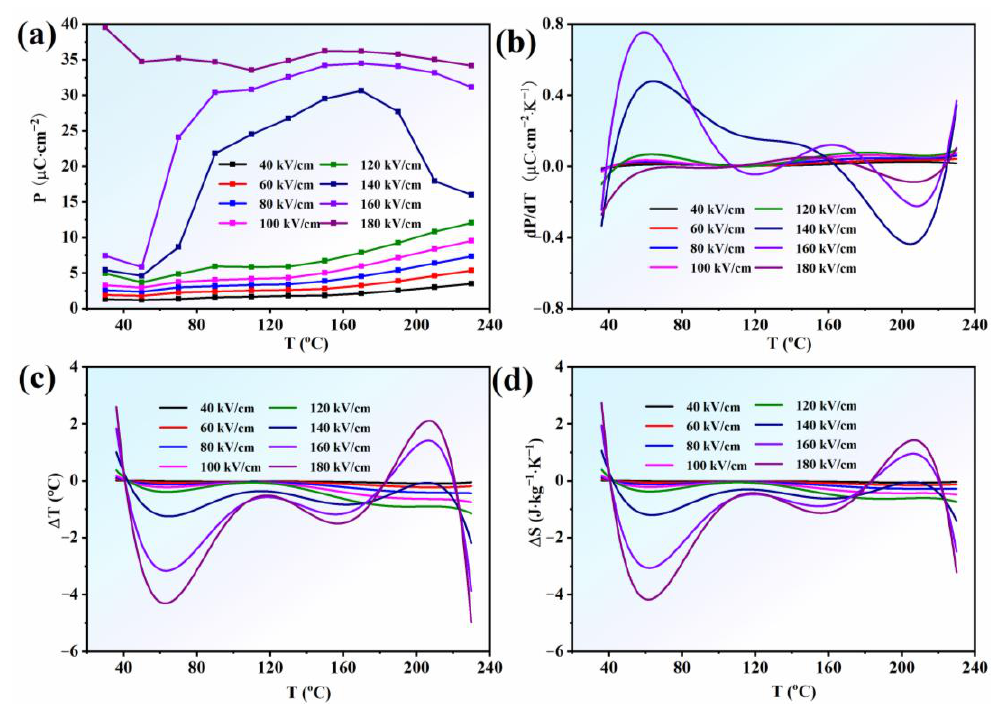
Figure 4. ( a ) the P max ; ( b ) dP/dT; ( c ) Δ T ; ( d ) Δ S as a function of temperature under different electric fields for AgNbO 3 ceramics.